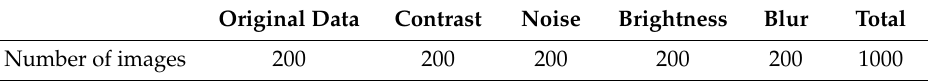
Figure 4. ( a ) Original picture; ( b ) contrast enhancement processing; ( c ) add noise processing; ( d ) brightness transformation; ( e ) blur processing. Table 1. The number of images generated by data augmentation technologies.